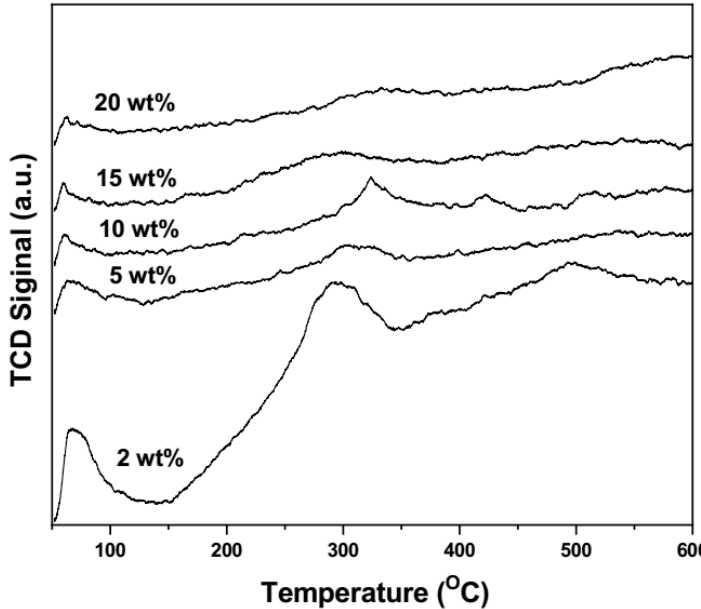
Figure 8. TPD profiles of various Cu/SiO 2 catalysts. Table 4. NH 3 -TPD of SBA-15 and different Cu/SiO 2 samples.